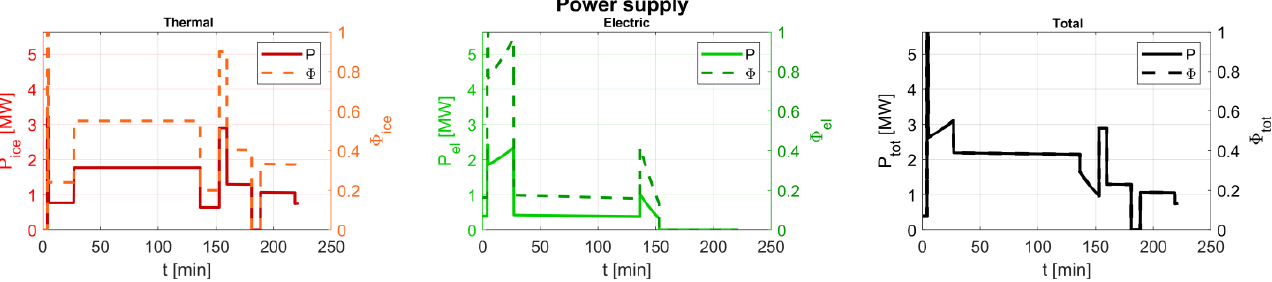
Figure 10. Mission simulation outcome: thermal (left), electric (centre), total (right) power sup- plied.